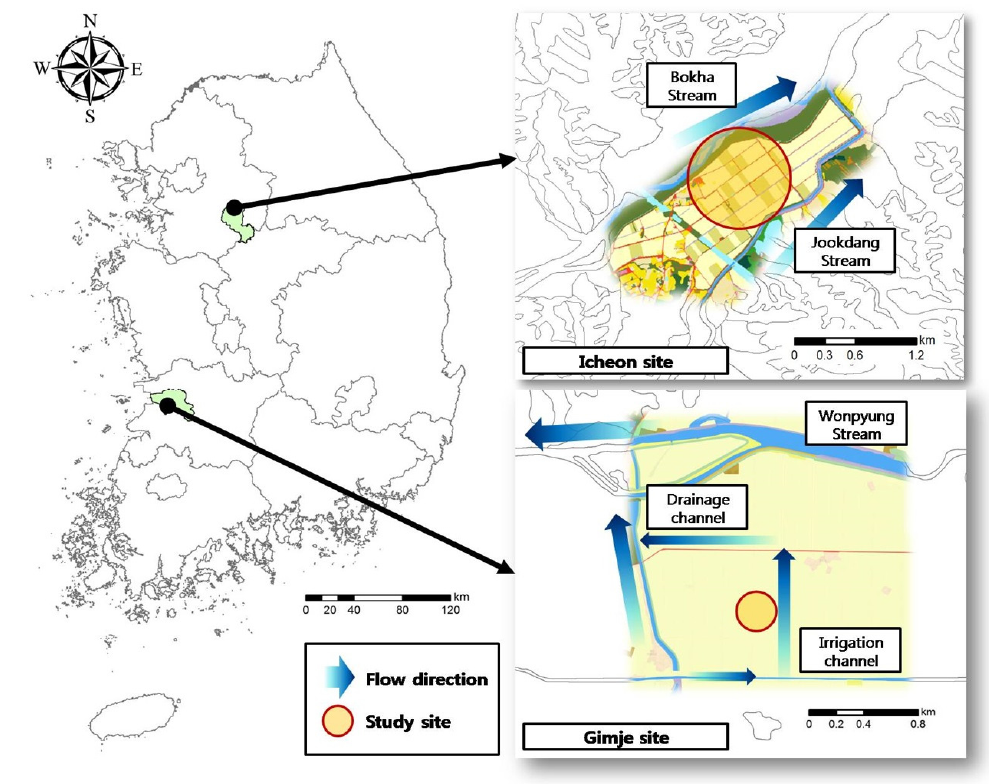
Figure 1. Topographical maps of the study areas. The Icheon site is located in province of Gyeonggi, and the Gimje site is located in the province of Jeonbug, South